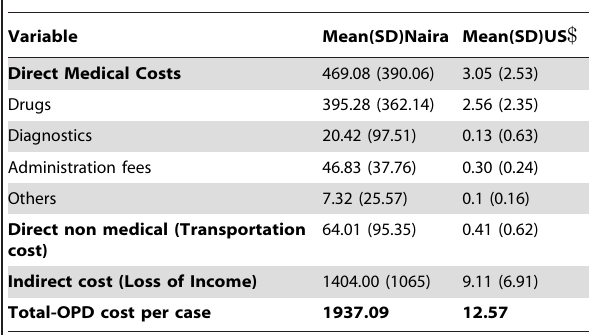
Table 2. Out-Patient Department (OPD) Costs.